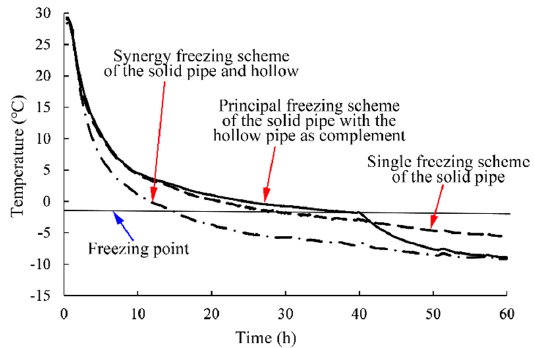
Figure 11 . The time ‐ temperature curve of soil between steel pipes (C2 ‐ N ‐ 16).